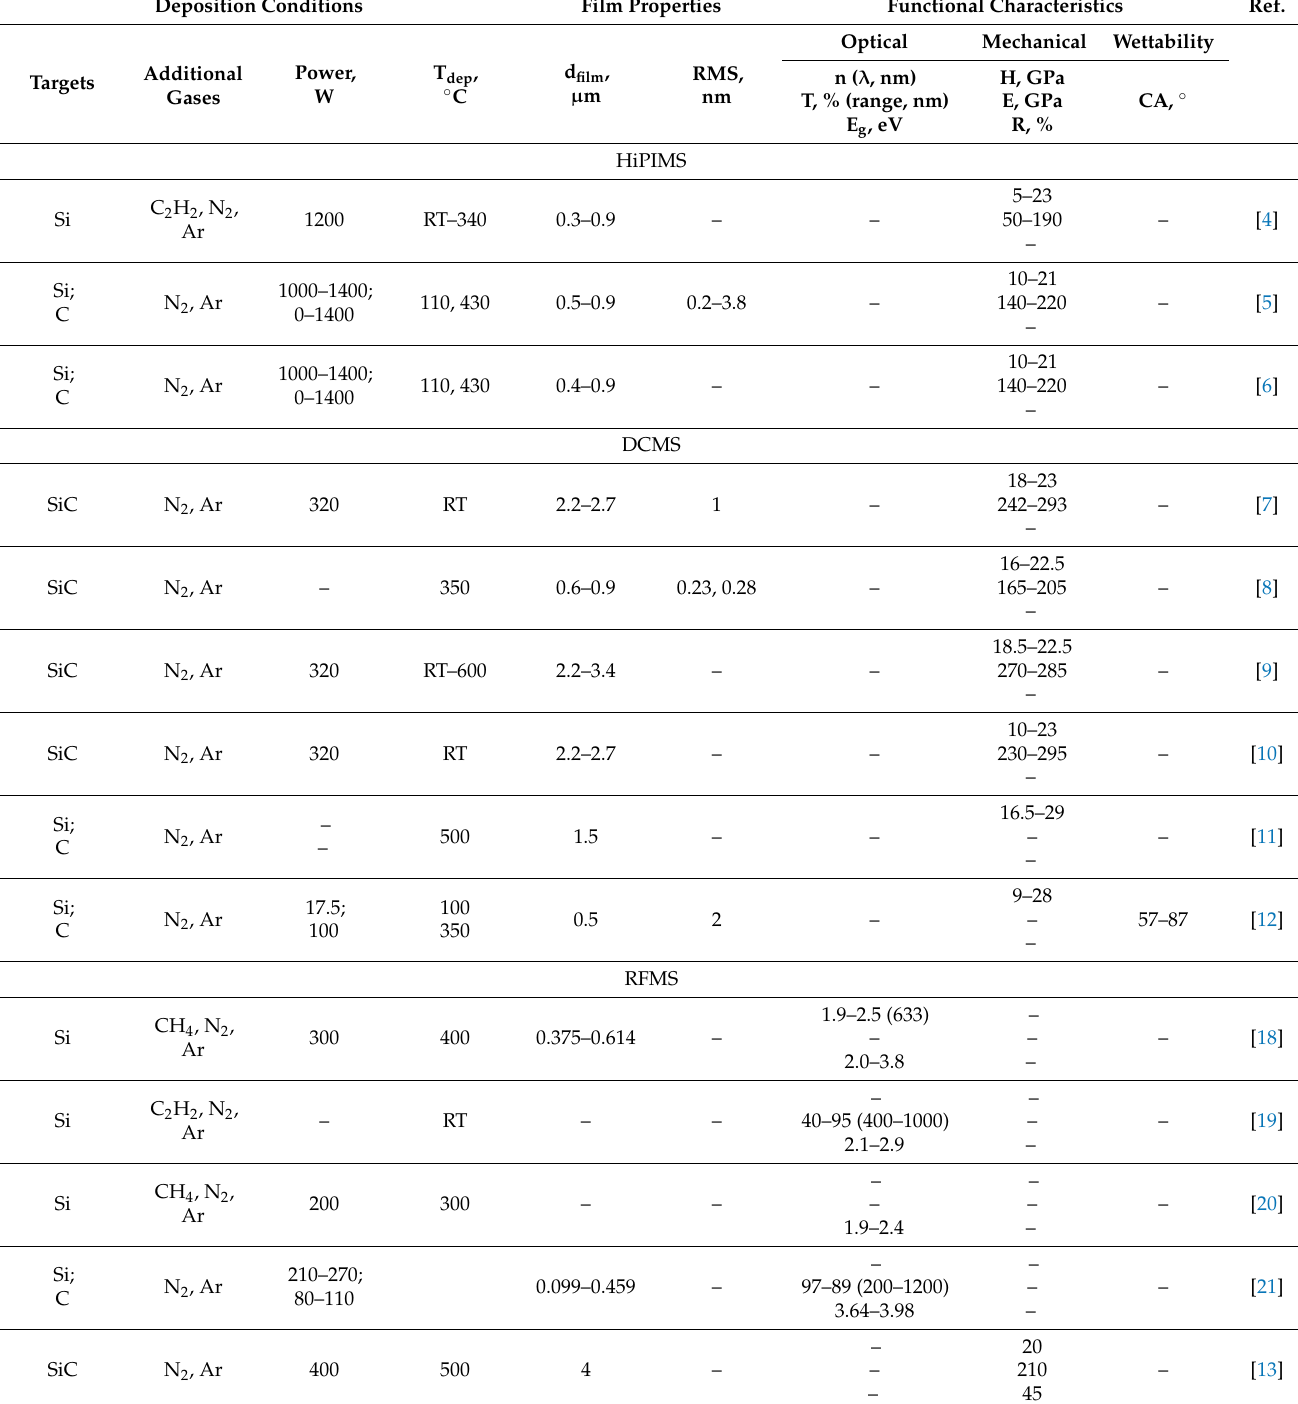
Table 1. Deposition parameters of PVD SiC x N y films and their functional